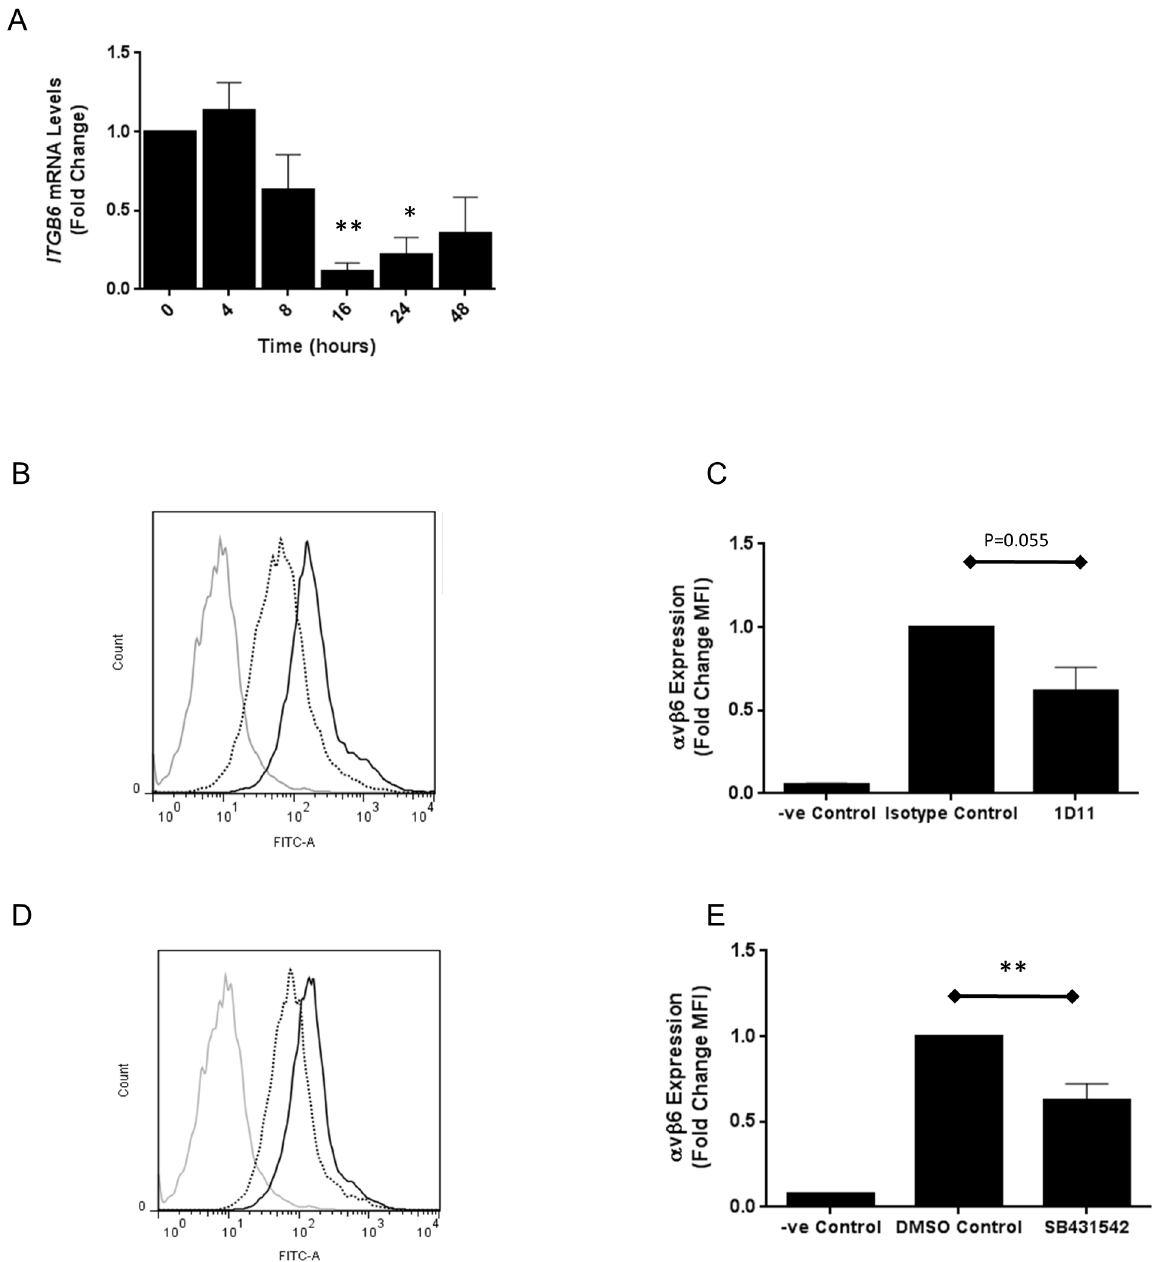
Fig 3. A. SAECs were treated with 10 μ M Alk5 inhibitor (SB431542) and ITGB6 mRNA was measured by QPCR at increasing time points. Data are expressed as mean expression relative to control (0 h) ± SEM from three independent experiments. * p < 0.05, ** p < 0.01 B. SAECS were treated with 10 μ g/ml anti-TGF β or an isotype control and α v β 6 cell surface expression measured by flow cytometry after three days. Three independent experiments were performed and the histogram shows representative data from one experimental repeat. Grey = negative control, black solid = isotype control, black dotted = anti-TGF β . C. Amalgamated data from three independent experimental repeats of the experiment described in Fig 3B are demonstrated as a bar chart showing mean fold change in MFI ± SEM. D. SAECs were treated with 10 μ M Alk5 inhibitor (SB431542), or an equivalent volume of the vehicle DMSO as a control, and α v β 6 cell surface expression measured by flow cytometry after three days. Three independent experiments were performed and the histogram shows representative data from one experimental repeat. Grey = negative control, black solid = DMSO control, black dotted = SB431542. E. Amalgamated data from three independent experimental repeats of the experiment described in Fig 3D are demonstrated as a bar chart showing mean fold change in MFI ± SEM. ** p < 0.01.